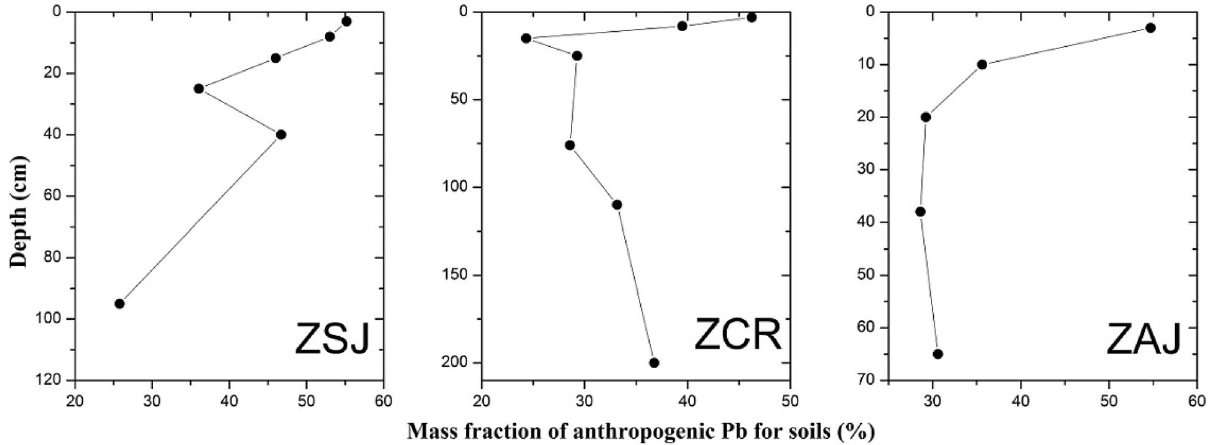
Figure 4. The location of sampling